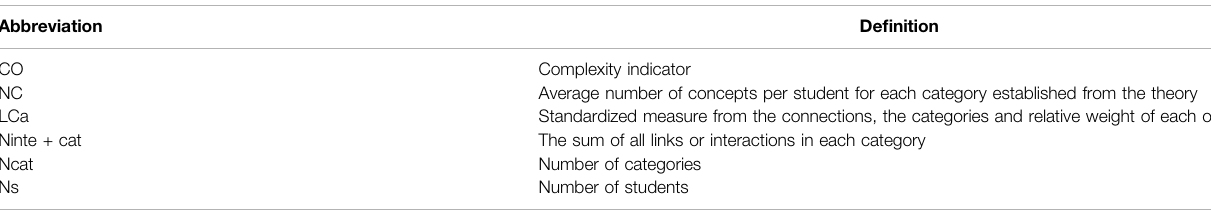
TABLE 2 | Metrics used in the complexity